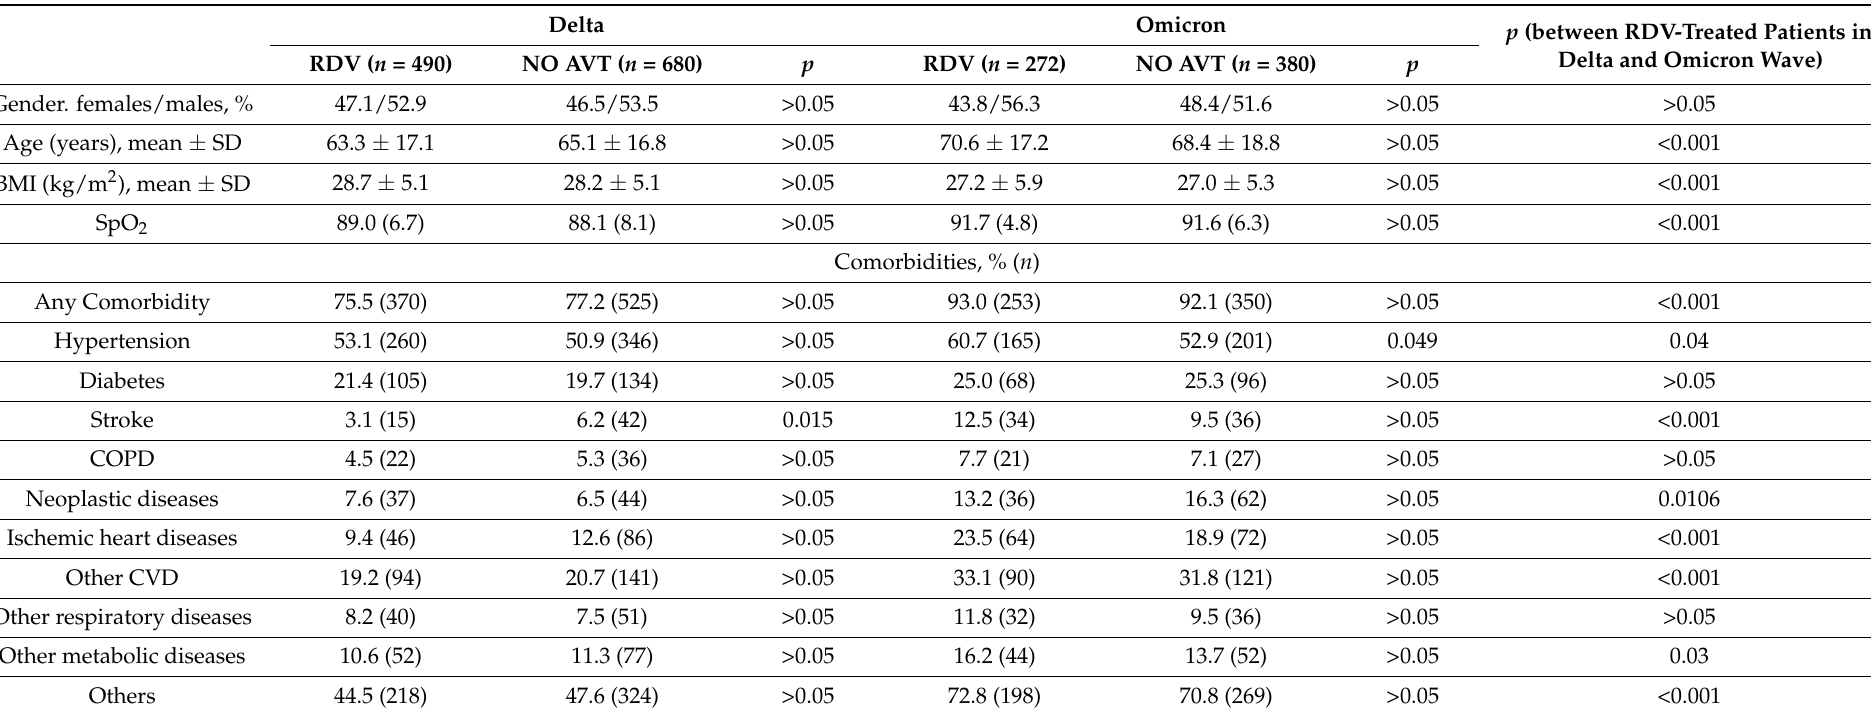
Table 1. Baseline characteristics of patients with COVID-19 hospitalized during Delta and Omicron waves with regard to RDV treatment. Delta Omicron p (between RDV-Treated Patients in